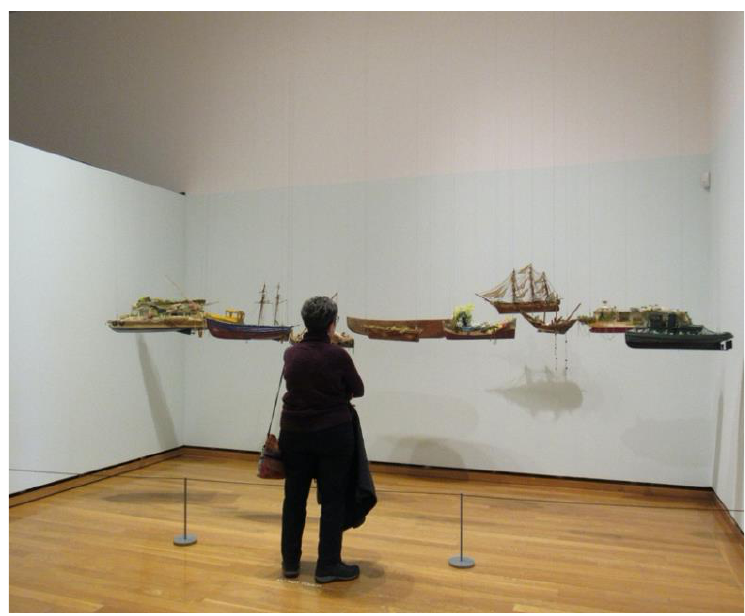
Figure 7 Hew Locke, The Wine Dark Sea (2016). Wood, metal, fabric, string, bamboo, paint, and plastic. Installation view of how the light gets in at Herbert F. Johnson Museum of Art, Cornell University, Ithaca (Photo: Author)